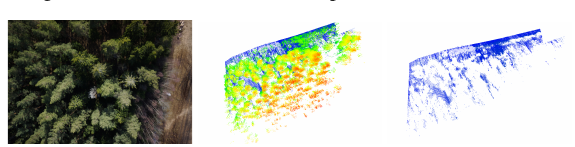
Figure 7: Deviation between the reference model and reconstruc- tion based on the two methods examined. The values of on the color bar are in meters. On the right side of each color bar the histogram of the error distribution is presented.